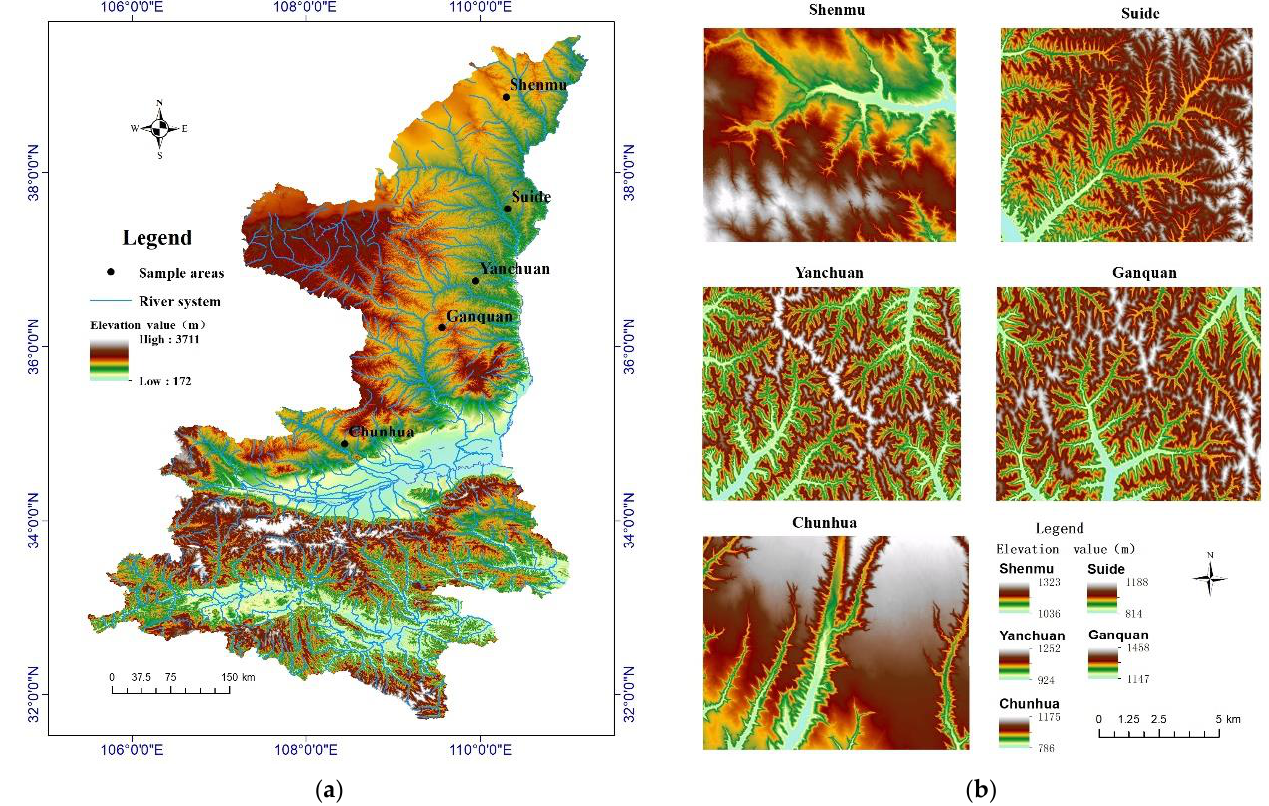
Figure 1. ( a ) The distribution of study areas; ( b ) hill shading of study